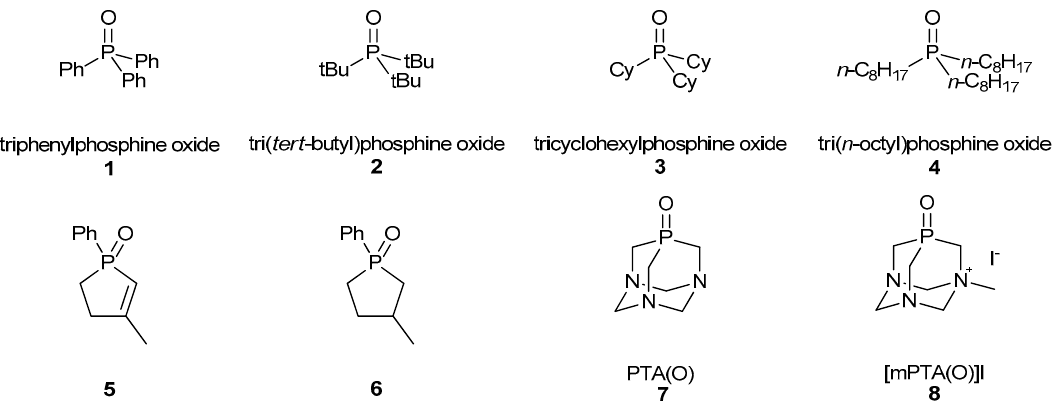
Scheme 4. Target substrates for P=O bond reduction using PMHS.